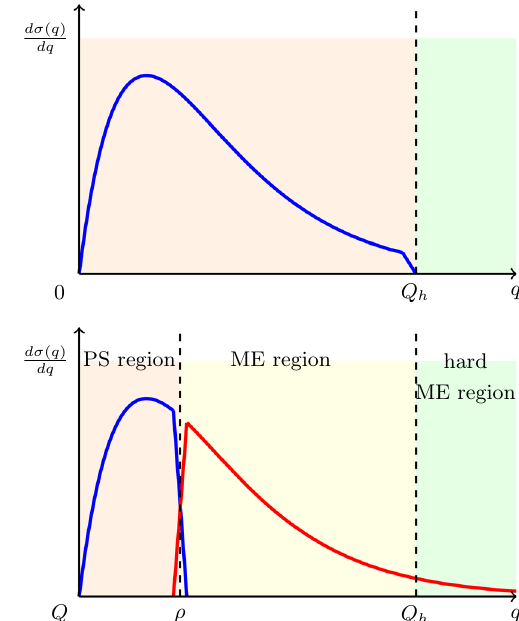
Fig. 2 Anillustrationofaschematic,infraredsensitiveobservable that receives contributions by both, parton showers and hard, additional jet production, which are reminiscent of a Drell–Yan p ⊥ spectrum. The top panel shows the shower prediction, with no radiation produced above a hard scale Q h , and the physical shape of the spectrum in the region of low transverse momenta. In the lower panel, we show the additional spectrum of a high- p ⊥ tail (in red) as populated by a cross section with an additional, hard jet. This spectrum would diverge towards low transversemomentaandsoacutneedstobeappliedatthemergingscale ρ , below which the phase space is populated by the parton shower. Merging algorithms need to consistently combine the two, avoiding missing or double-counted contributions around the merging scale